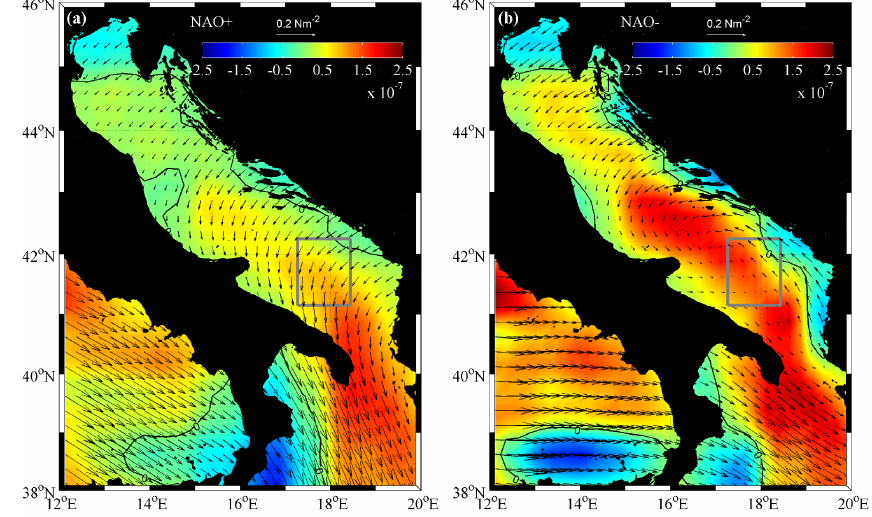
Figure 7. Spatial distribution of the mean JFM wind-stress vorticity (colours; Nm − 3 ) and wind-stress vectors (arrows; Nm − 2 ) in the positive NAO phase (a) and negative NAO phase (b) , 1988–2011. The squares show the areas used to estimate the time series in Fig.